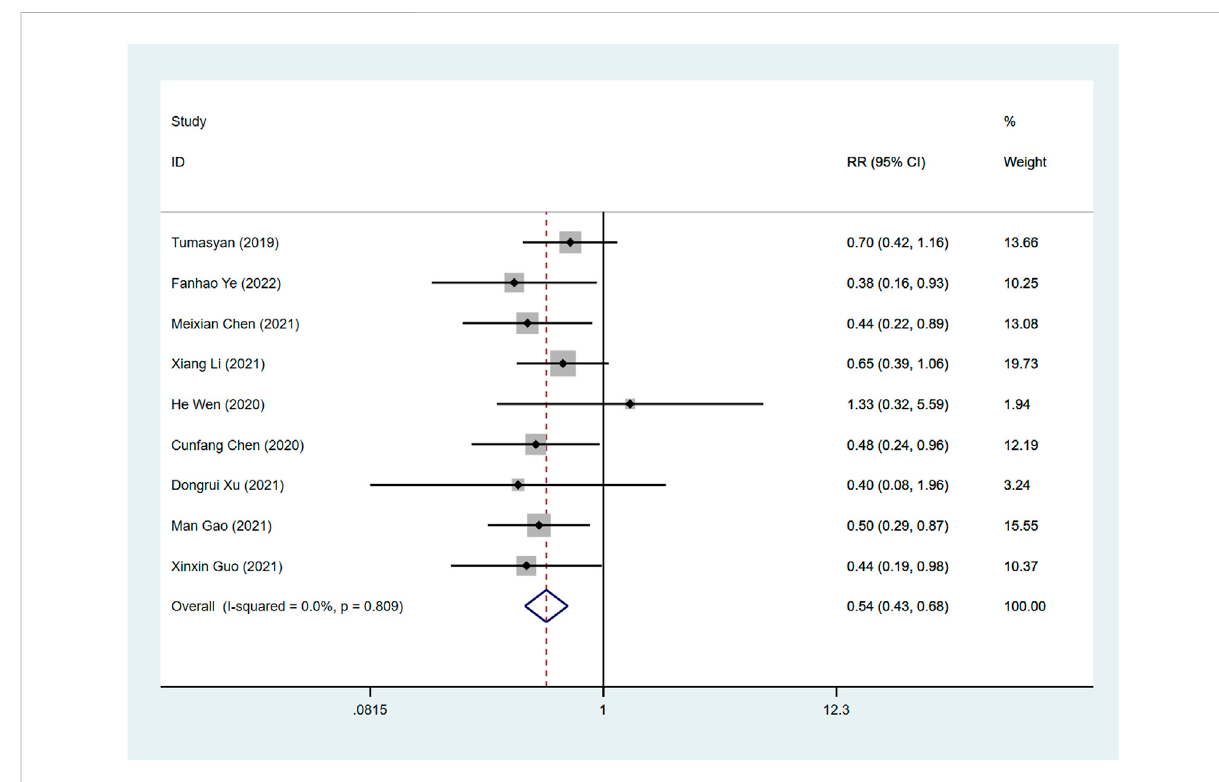
FIGURE 8 Forest plot of readmission rate between sacubitril-valsartan and ACEI or